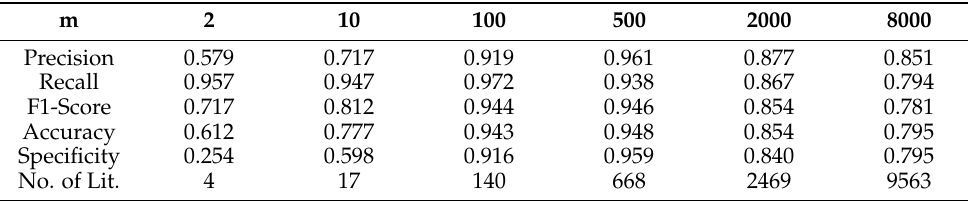
Table 12. Performance of TM with SSL continuous feature scheme on Balance Scale